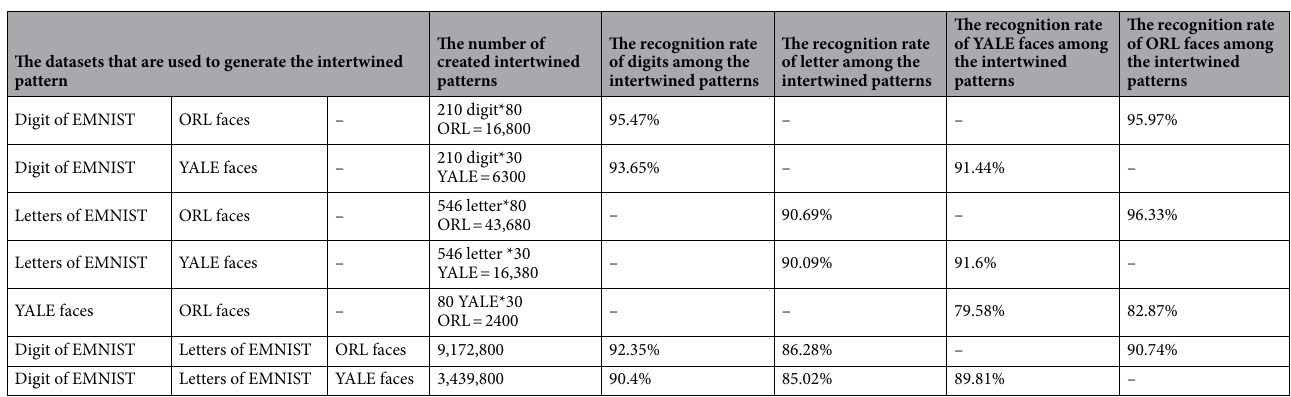
Table 6. The rate of correct recognition of system configuration Fig. 8 in classifying the intertwined patterns, which were obtained from the combination of patterns of two or three